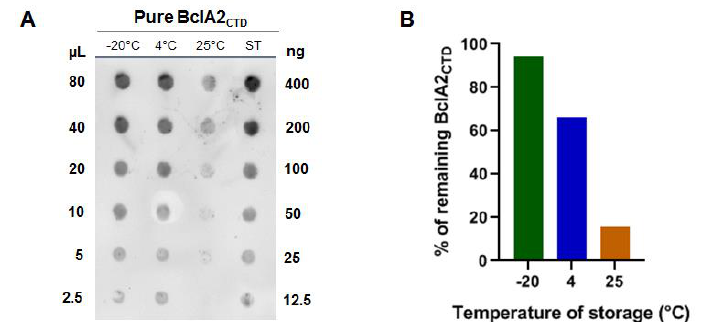
Figure 2. Stability of purified BclA2 CTD . ( A ) Dot blotting of purified BclA2 CTD stored for 2 d at −20, +4, or at +25 °C with anti-6x His antibody. The protein stored at −80 °C right after purification (ST) was considered as standard. Loaded volumes of purified protein (μL) and known amount of the standard (ng) are indicated. ( B ) Plot of the densitometric analysis of dot blot experiment of panel A, considering the amount of protein stored at −80 °C as 100%.